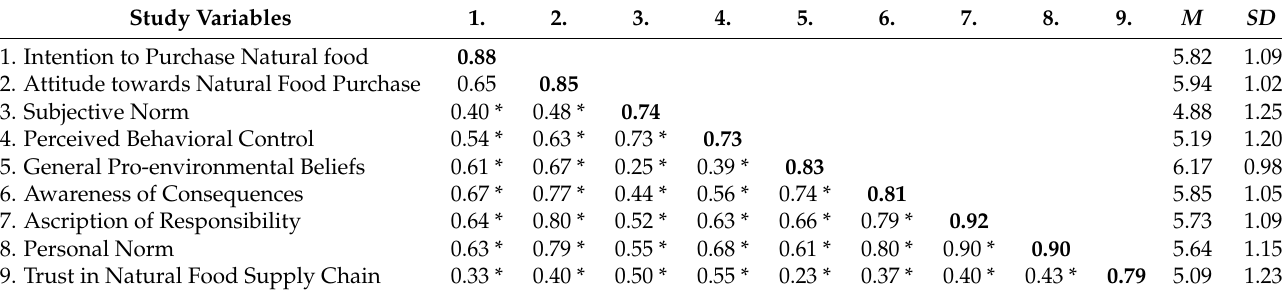
Table 2. Means, correlations, and AVEs of the study variables.